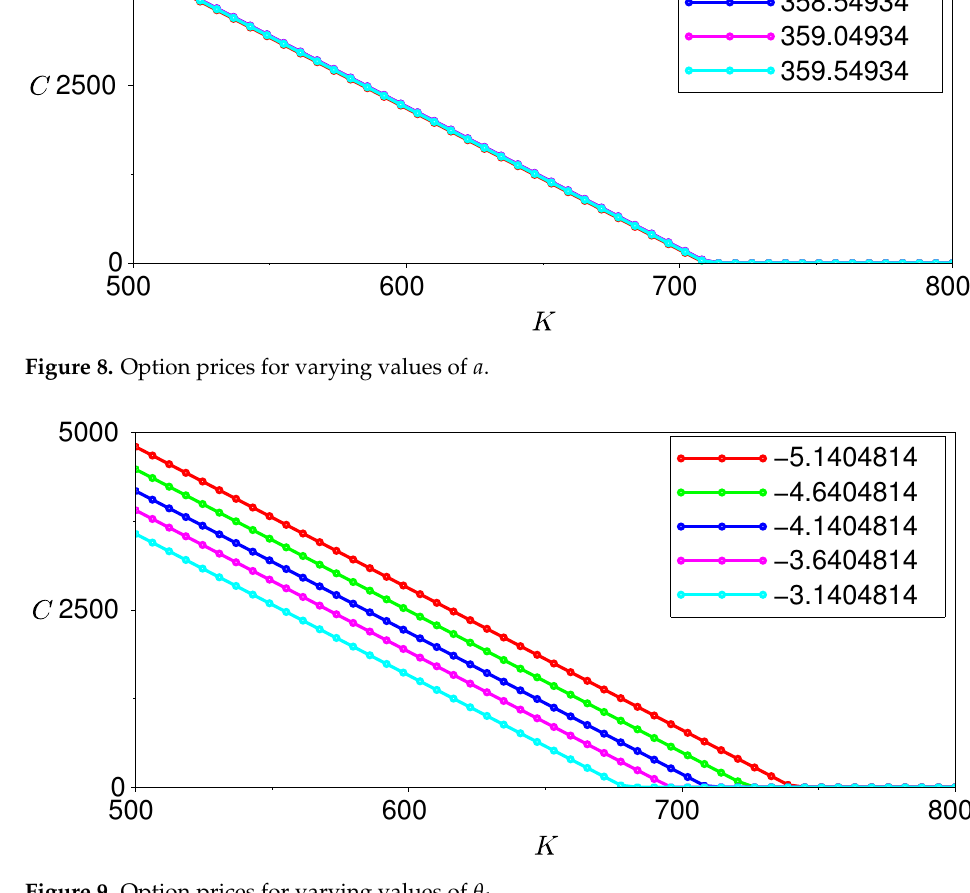
Figure 9. Option prices for varying values of θ 1